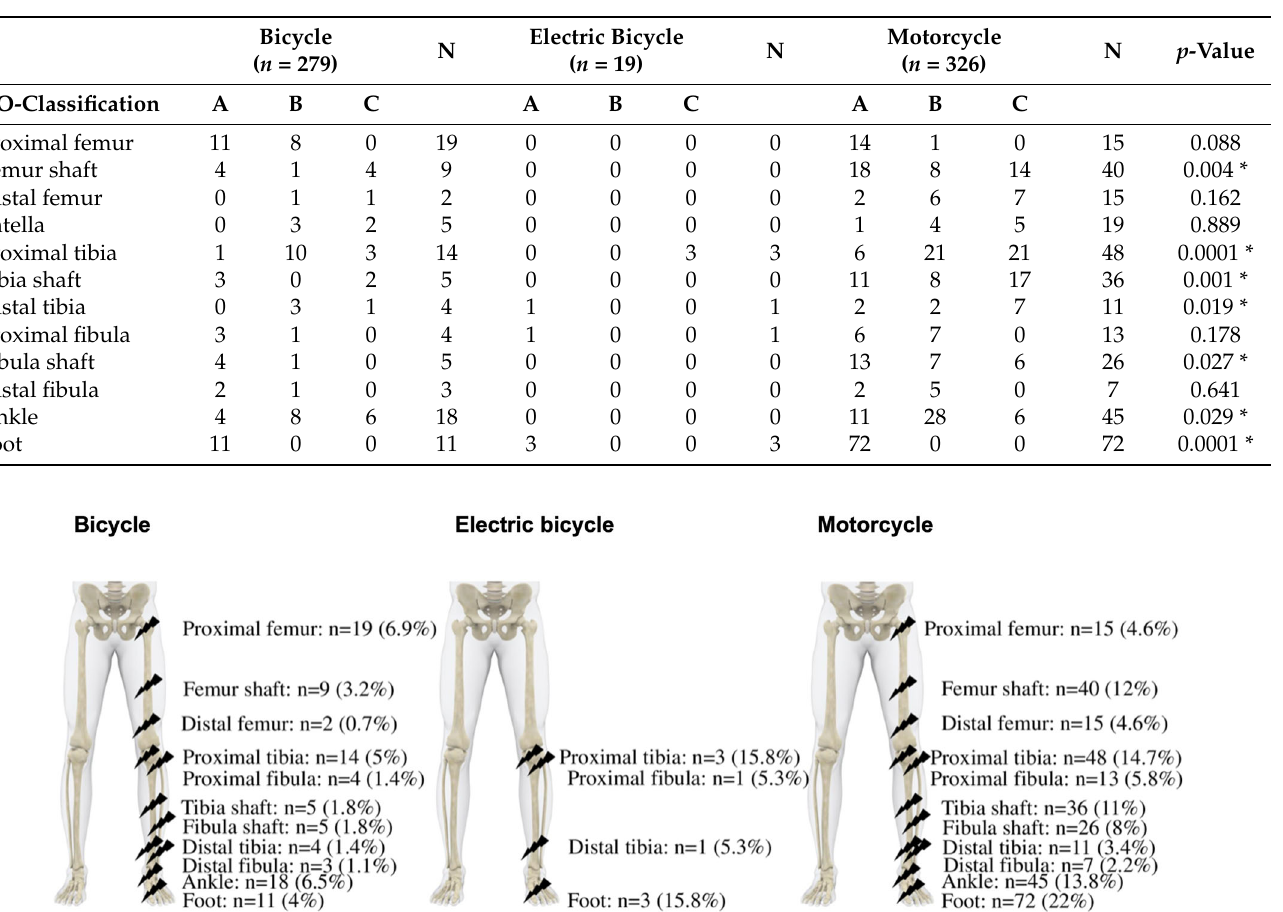
Table 1. Distribution of fractures stratified by vehicle. The table shows the total number of fractures stratified by the used vehicle. N shows the total of patients in each vehicle group. Chi ‐ square test was used to determine differences between the vehicle groups. * Indicates statistical significance.